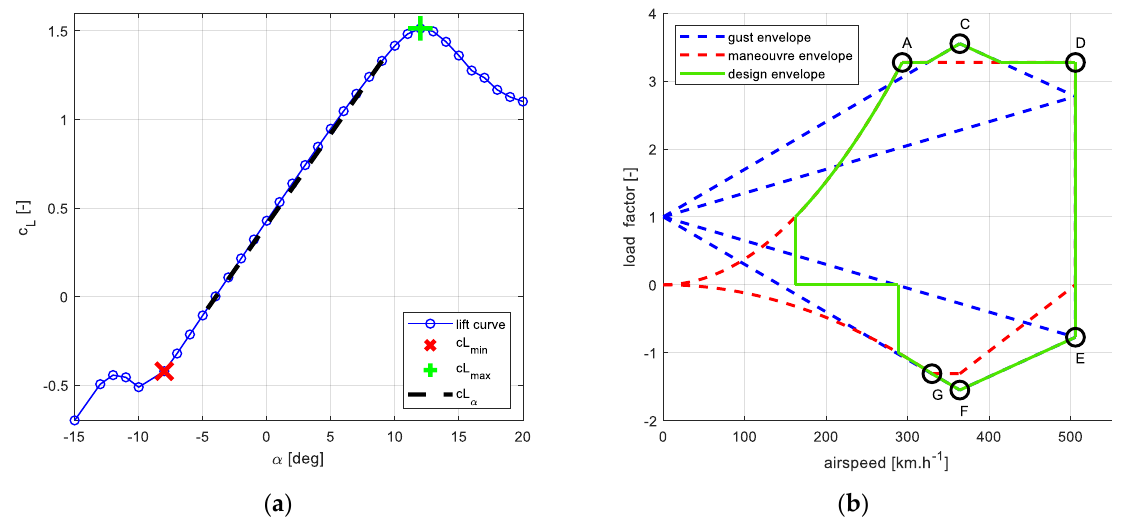
Figure 10. The lift curve of the wing ( a ); flight design envelope ( b ).